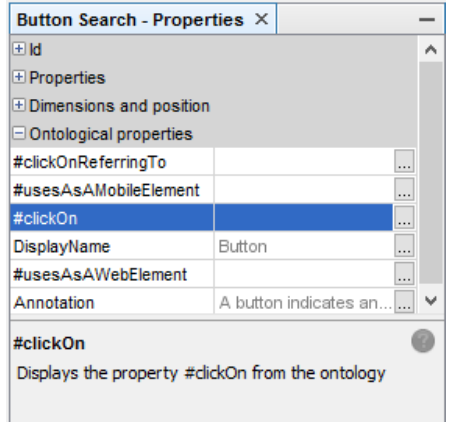
Figure 26. Example of results given during